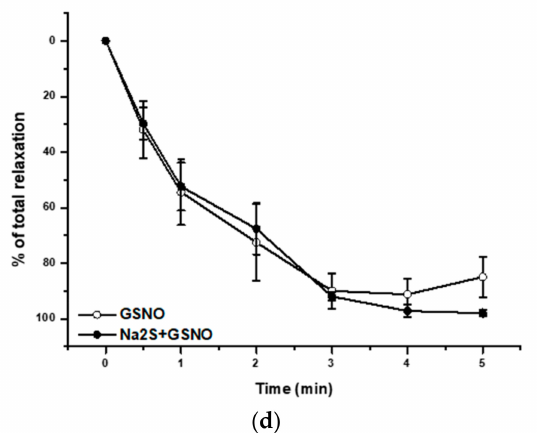
Figure 3. The comparison of the vasorelaxation induced by GSNO alone and after incubation with Na 2 S. Original record of the incubation with Na 2 S (40 µ M) ( a ). The comparison of the maximal relaxation ( b ) and the absolute ( c ) as well as the relative ( d ) relaxation in time induced by GSNO (0.5 µ M) alone and by GSNO (0.5 µ M) after incubation of the precontracted aortic rings with Na 2 S (40 µ M) ( n = 8). Values are mean ± S.E.M. * p <